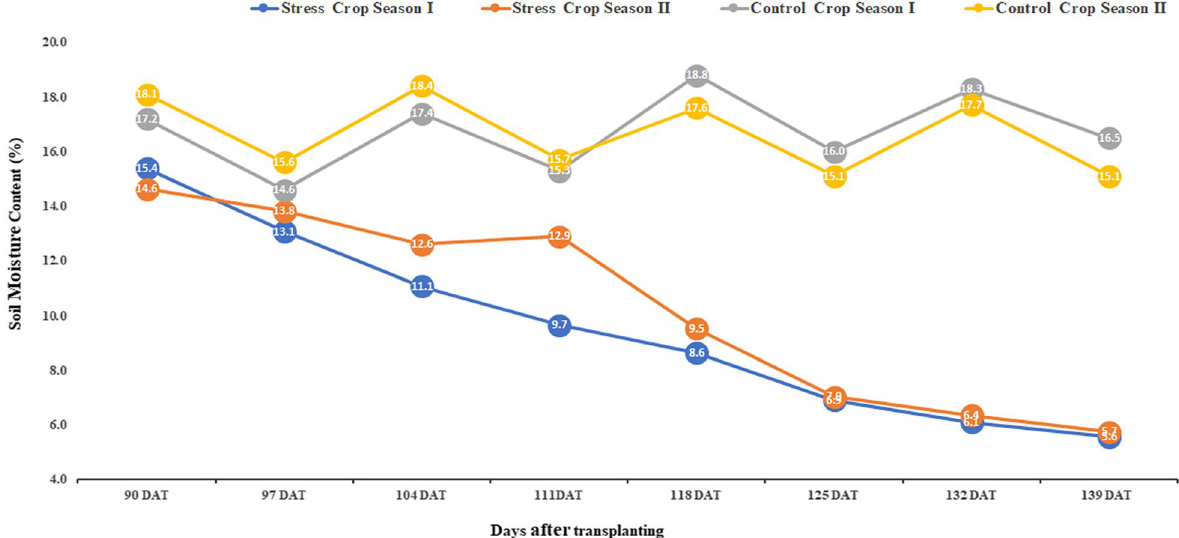
Fig. 1 Periodic soil moisture content (5–10 cm depth) of the experimental plots during 90–140 DAT of Andrographis